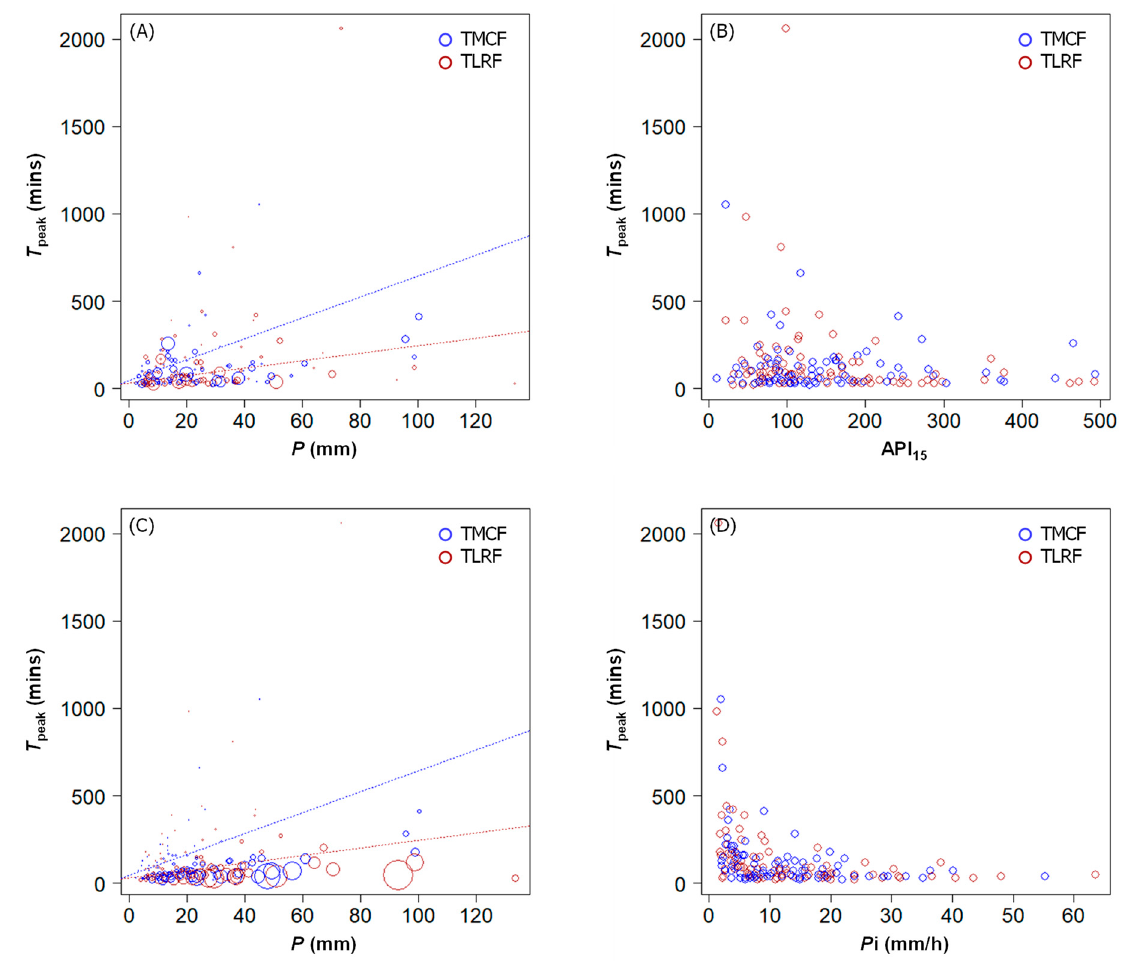
Figure 4. ( A ) T peak versus event rainfall, increasing point size corresponds to increasing API 15 ; ( B ) T peak versus secondary predictor (API 15 ); ( C ) T peak versus rainfall, increasing point size corresponds to increasing P i; and ( D ) T peak versus secondary predictor ( P i). T res was not explained by the primary predictor, P , but had a significant relationship with P i (Figure 5; p < 0.05). T res in the TMCF was 1.7x longer than in the TLRF ( p < 0.05).